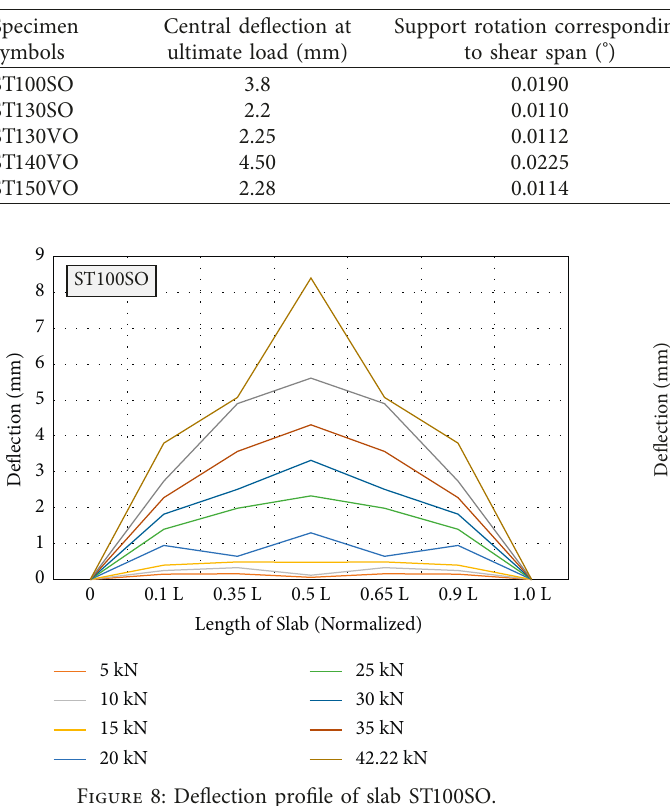
Table 5: The support rotation magnitude for the tested specimens.